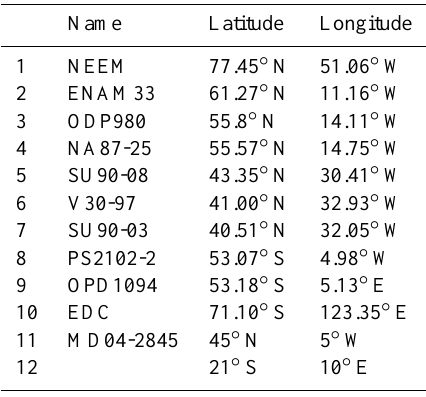
Table 2. Location of the study sites, including marine and ice core sites. Site (12) corresponds to an unpublished marine core for which only the simulated temperature is